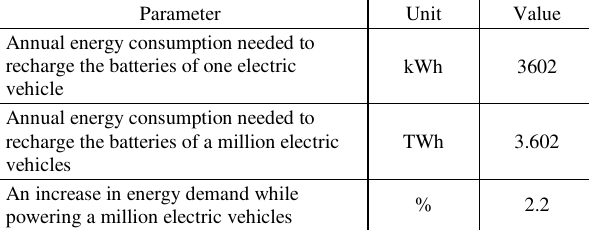
Table 5. Energy demand for powering electric